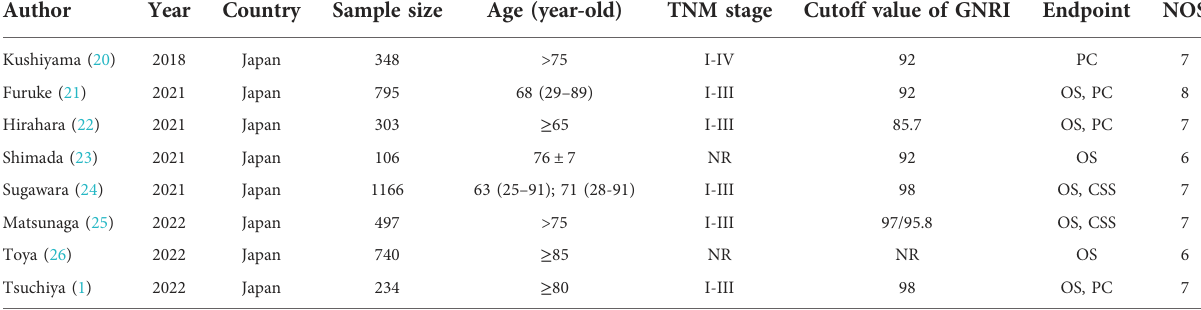
TABLE 1 Basic characteristics of included studies.